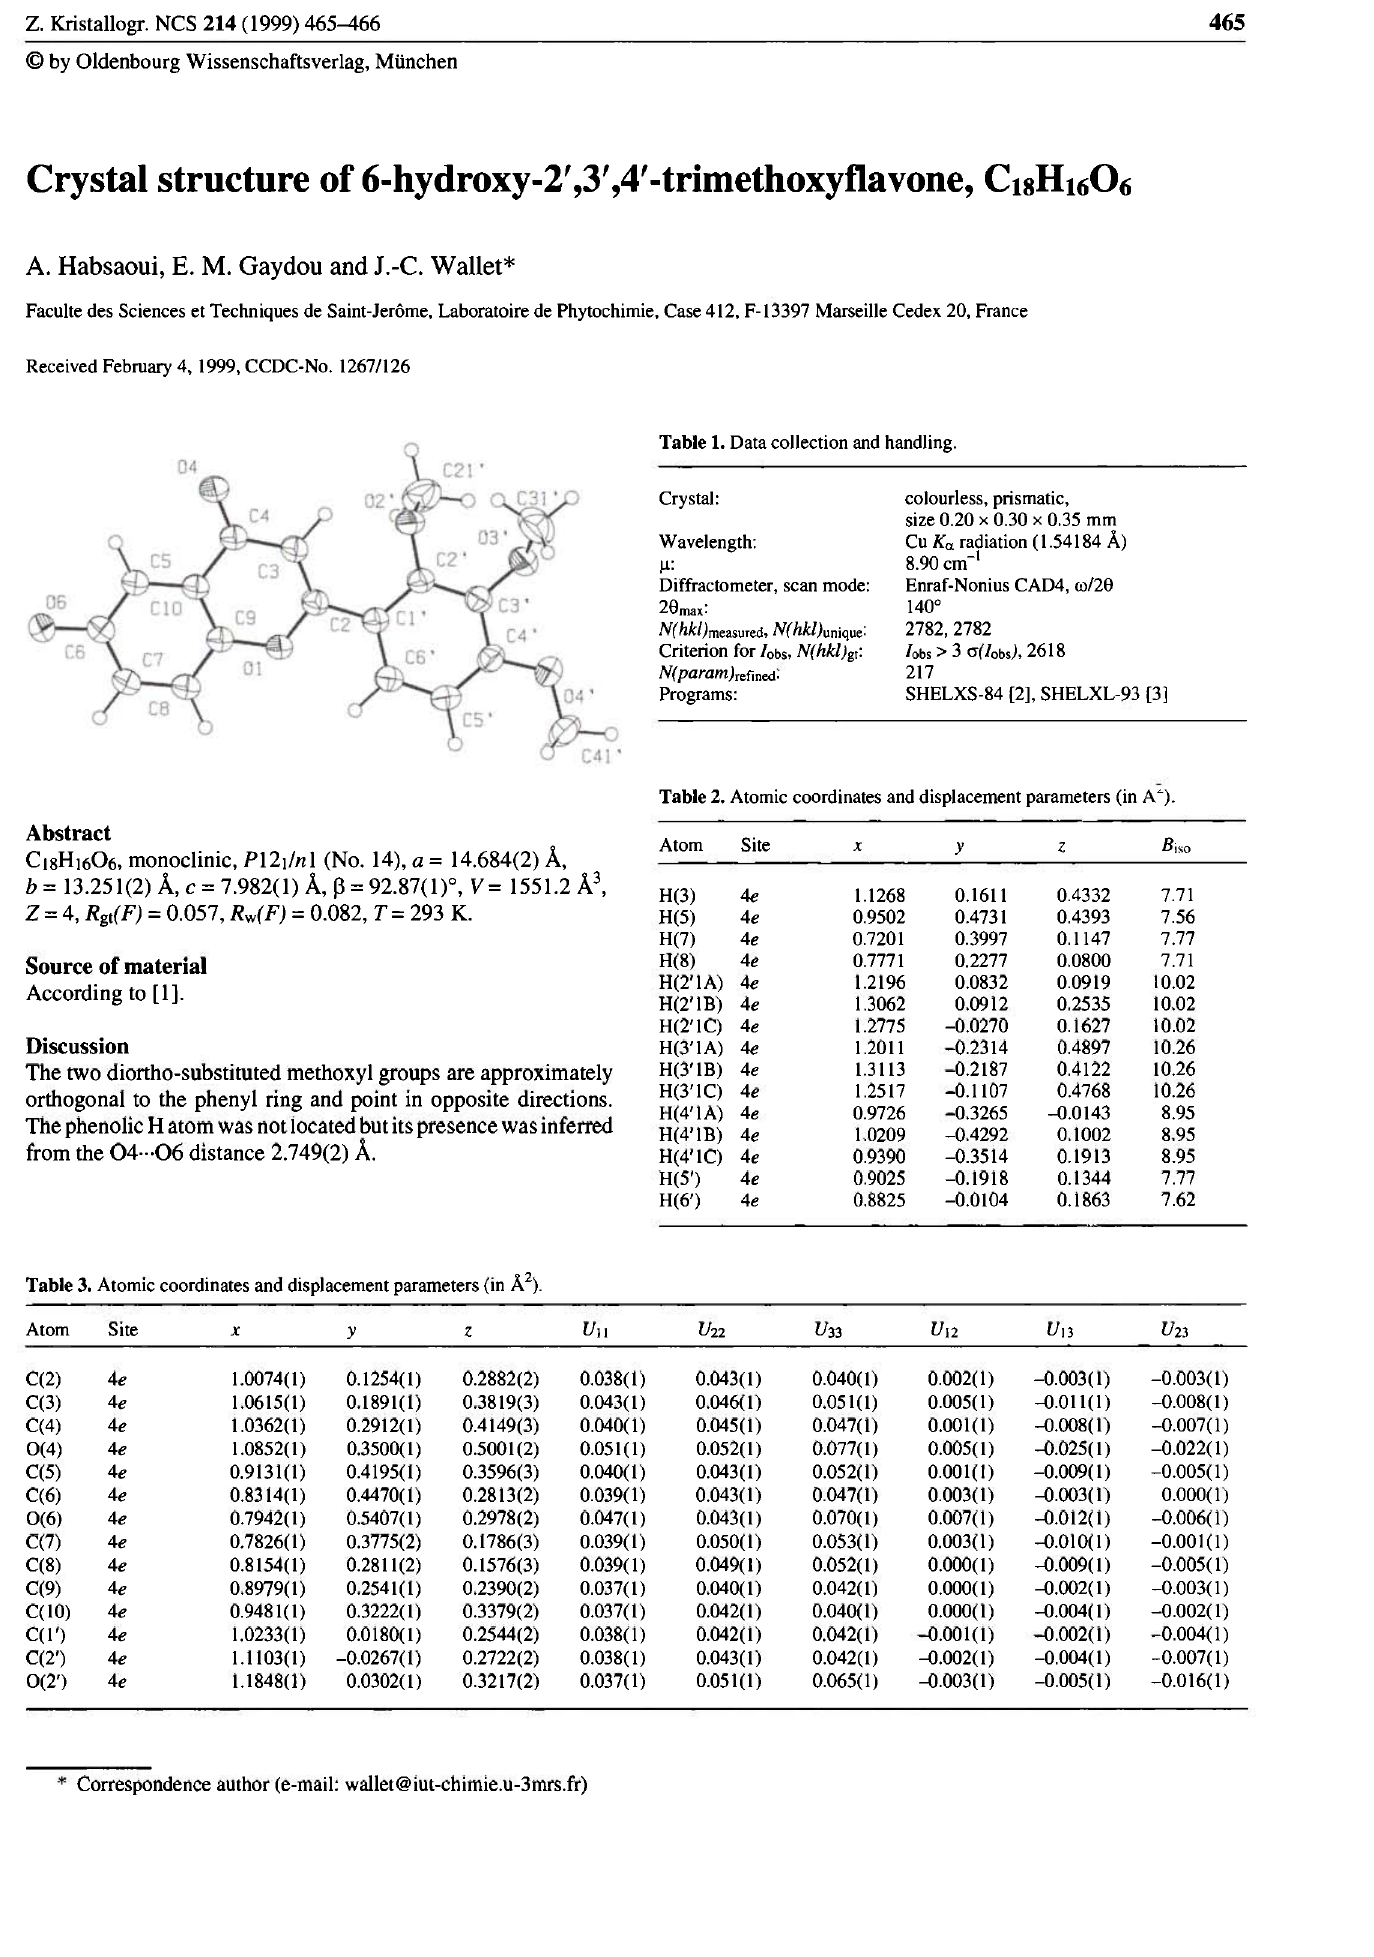
Table 3. Atomic coordinates and displacement parameters (in Ä 2